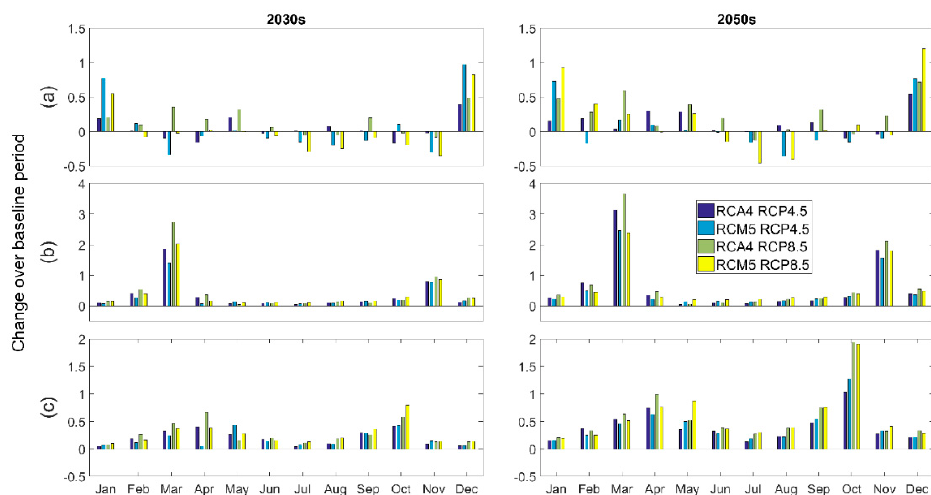
Figure 5. Average annual monthly bias corrected projected change in climate variables relative to the baseline period (1988—2017): ( a ) precipitation in mm, ( b ) maximum temperature in °C, and ( c ) minimum temperature in °C.